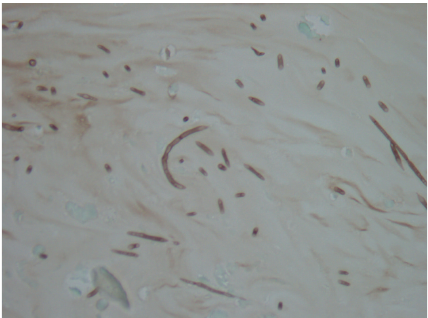
Figure 4: Collection of septate hyphae consistent with Aspergillus species. Methenamine silver, ×